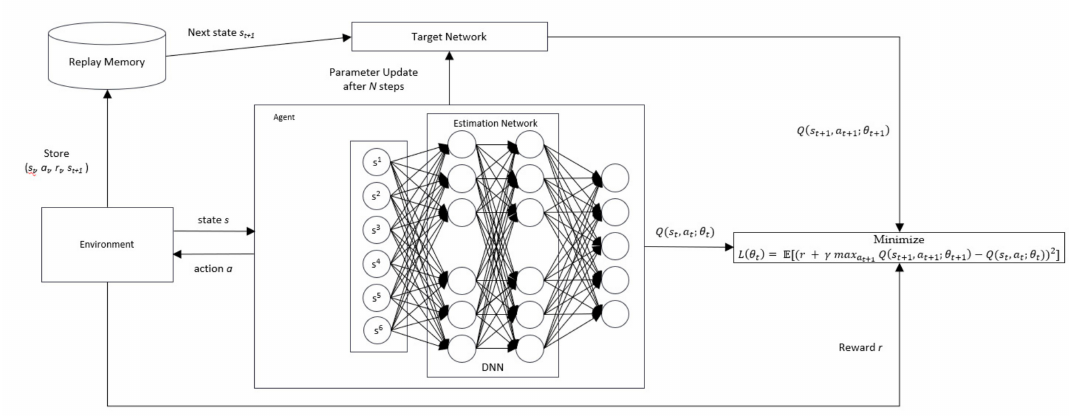
Figure 4. Deep Q-Network